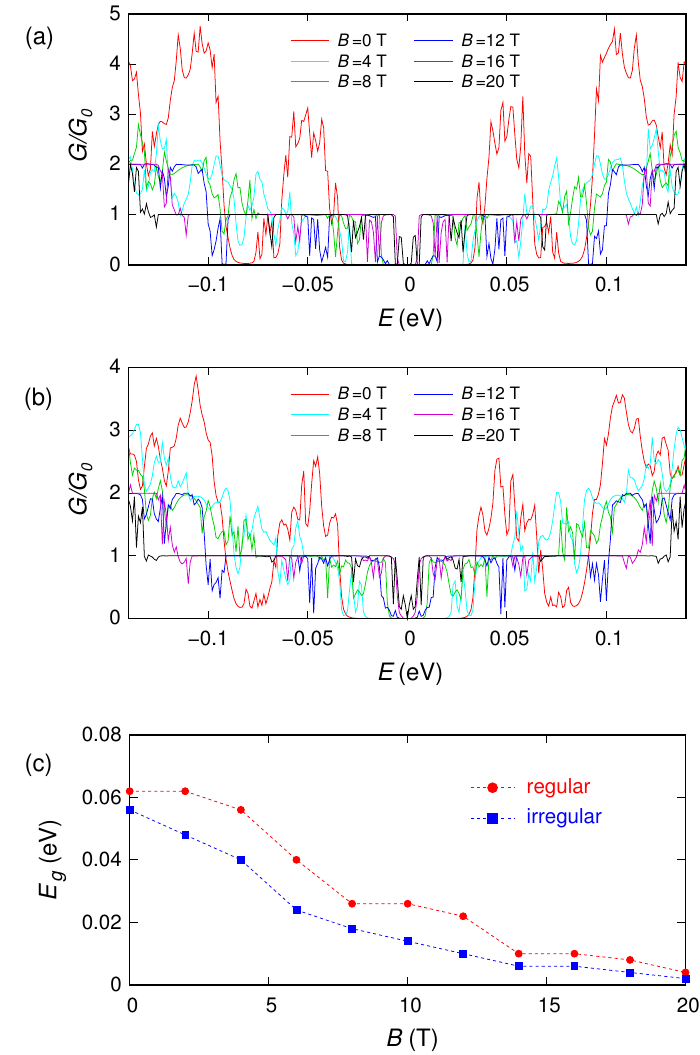
Figure 6. Normalized conductance as a function of the Fermi energy E for 6 values of the magnetic field, for the ribbon with an ordered ( a ) and a disordered ( b ) distribution of antidots. In panel ( c ) we report the behavior of the energy gap as a function of the magnetic field for the two different distributions of